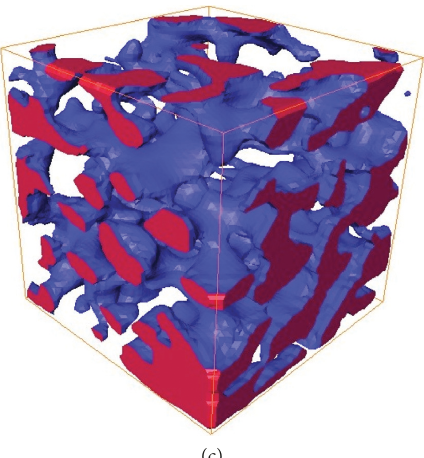
Figure 7: Model of coal’s micropore structure in model P 28.77%).